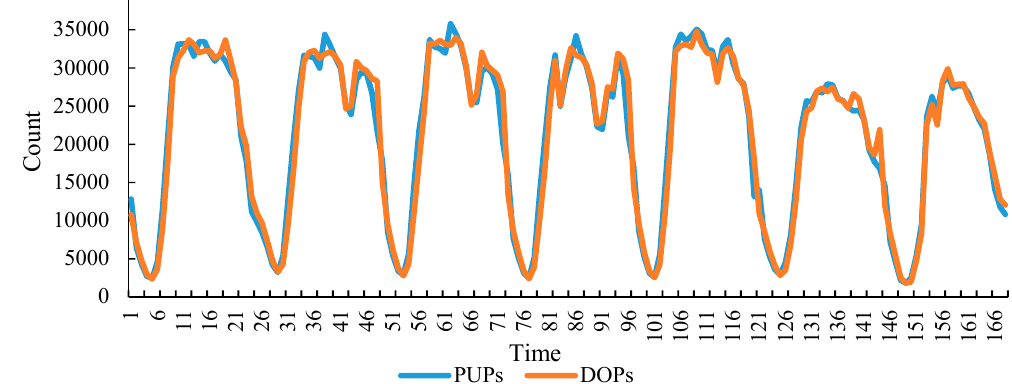
Figure 6. Curves of S P and S D representing temporal variations of PUPs and DOPs for the entire study area.